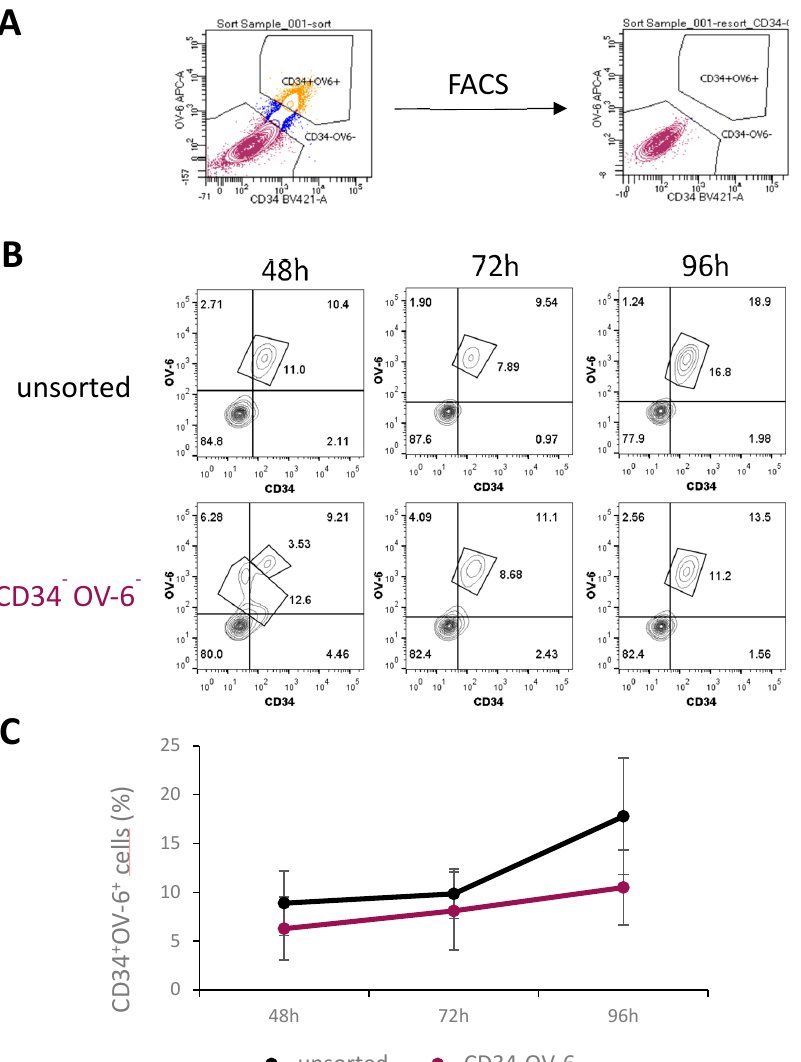
Figure 2. CD34 + OV-6 + CD90 + csVimentin + PD-L1 + CSCs can originate from CD34 − OV-6 − non-CSCs. ( A ) CD34 − OV-6 − HuH6 cells were sorted by FACS and plated out in 6-well plates along with unsorted control cells. ( B ) After 48, 72 and 96 h, cells were measured for CD34 expression and OV-6 binding using flow cytometry. These are representative results of 5 experiments. ( C ) The values are the means, which are presented with error bars depicting the standard deviation from the